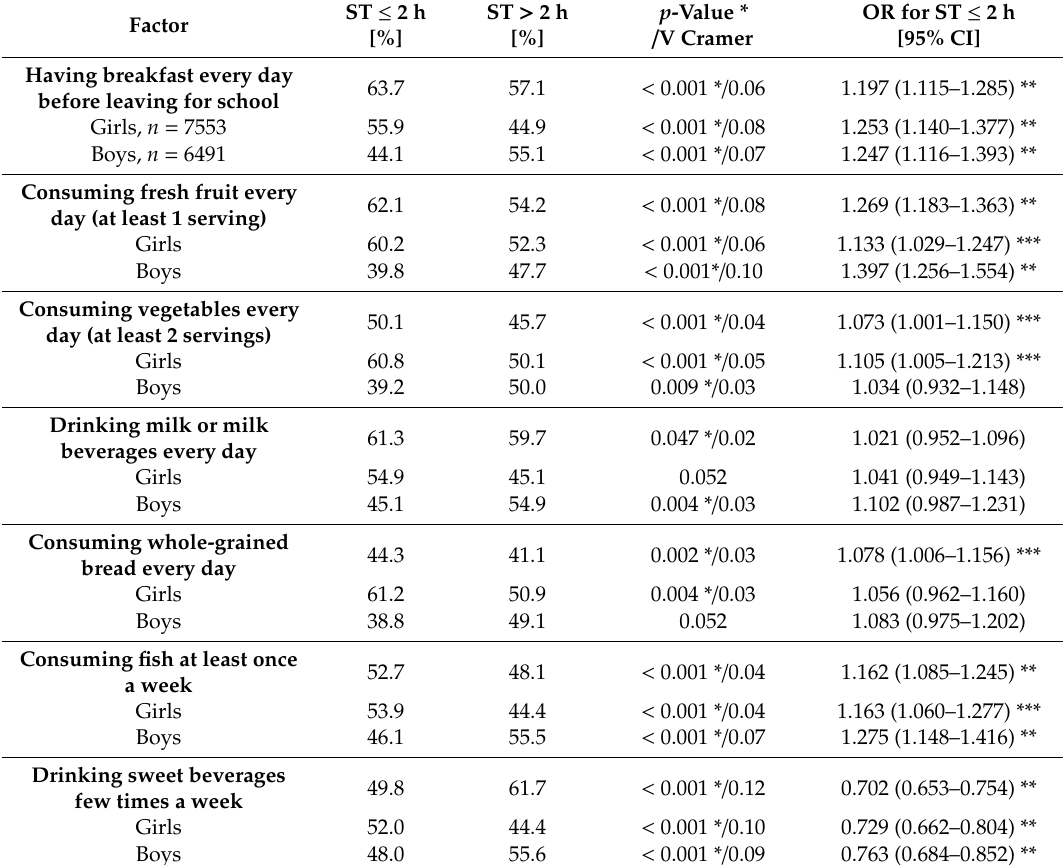
Table 3. Nutritional behaviors of the individuals ( n = 14,044) depending on screen time (ST) duration and the logistic regression analyses for the association of meeting ST recommendations ( ≤ 2 h) on nutritional behaviors (OR, odds ratio; CI, confidence